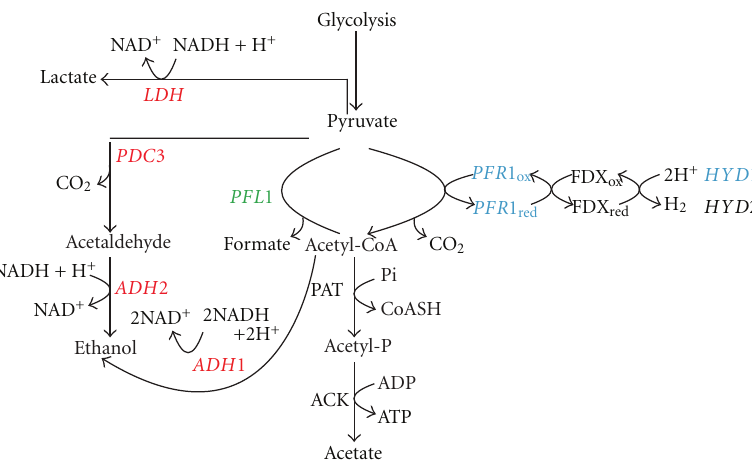
Figure 4: Diagram depicting the fermentative pathways of Chlamydomonas split into 3 functional subpaths based on response profile to circadian inputs, light (dark), and oxygen in cells synchronized to a 12h:12 h light:dark photoperiod and grown at 23 ◦ C. In red: LDH1, ADH1, ADH2, and PDC3 which are under circadian regulation. In green: PFL1 which did not show a circadian pattern of expression, nor did it respond to changes in light (dark) or oxygen. In blue: PFR1 and HYD1 which both show circadian expression patterns and are also responsive to changes in oxygen, but not to changes in